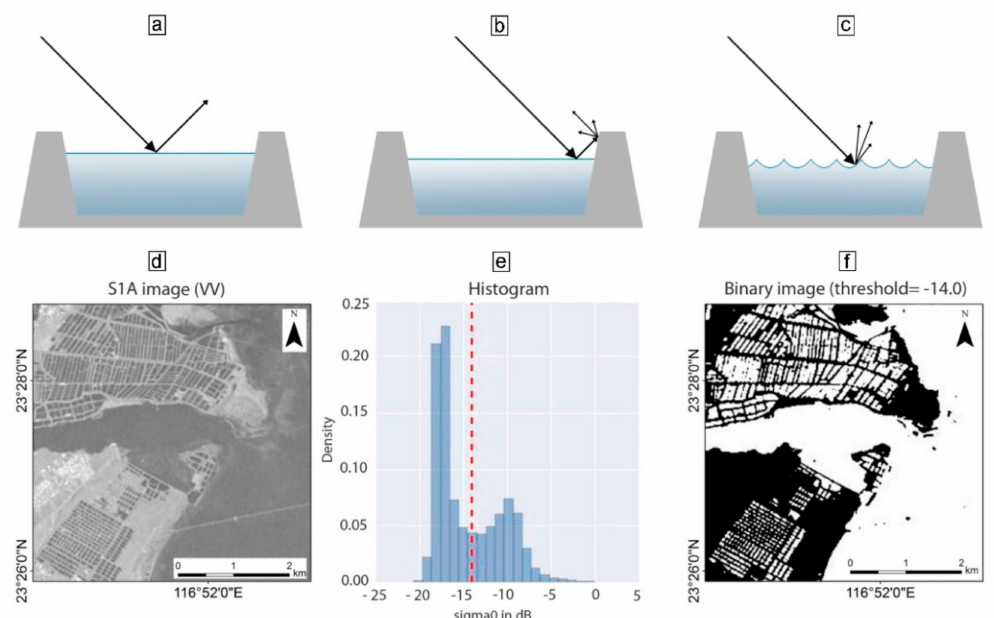
Figure 9. (Top) Examples of radar interaction with aquaculture ponds: ( a ) specular reflection (smooth water surface); ( b ) corner / embankment; and ( c ) di ff use reflection (rough water surface). (Bottom) S1A image ( d ); related histogram and classification threshold ( e ); and binary image of water and non-water after application of threshold ( f ). (Modified from Ottinger et al.